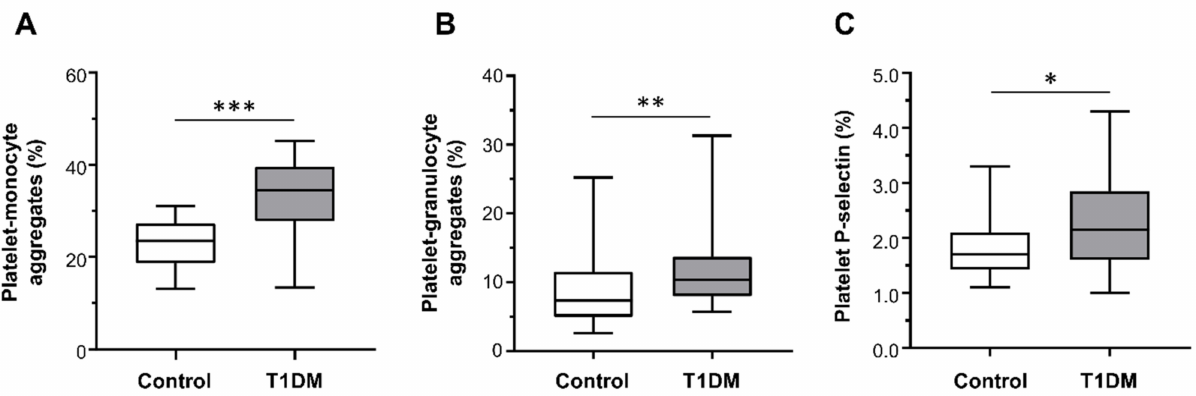
Figure 2. Platelet–monocyte aggregates ( A ), platelet–granulocyte aggregates ( B ), and platelet P-selectin expression ( C ) de- tected ex vivo, by flow cytometry, in healthy controls ( n = 28) and type 1 diabetes mellitus (T1DM) patients ( n = 28). Data were represented as median (range). p -values by Mann–Whitney test (( A ) *** p < 0.001, ( B ) ** p < 0.01, and ( C ) * p < 0.05).